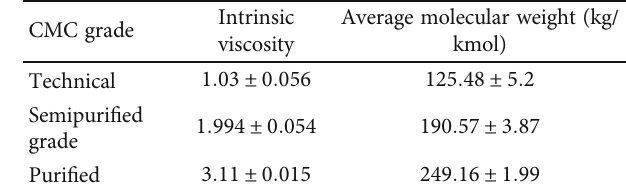
Table 6: Intrinsic viscosity and molecular weight of prepared